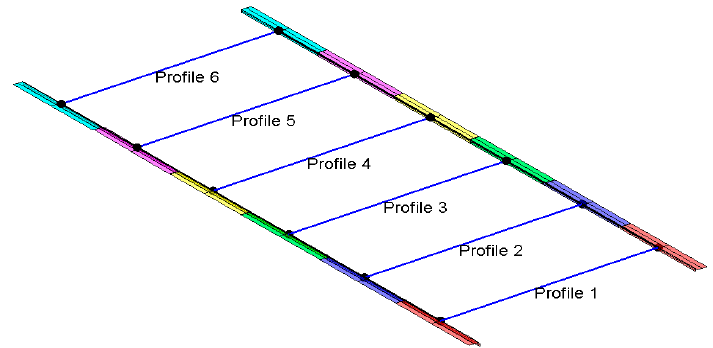
Figure 11. Three-dimensional (3D) presentation of the part of the crane rails with profiles.